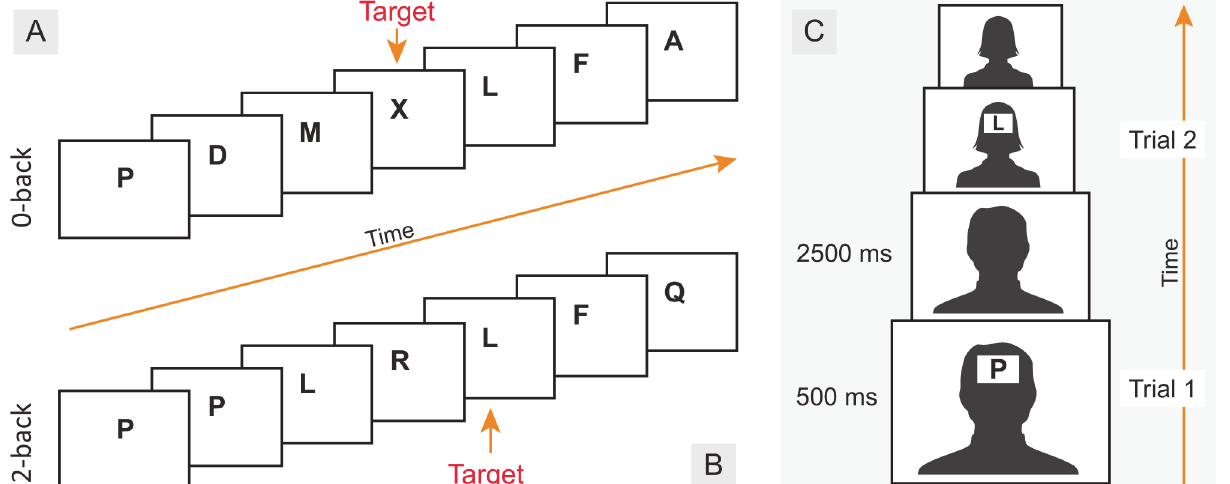
Fig 3. Illustration of the n -back tasks. A. The target in the 0-back control condition is any letter designated in the instructions (e.g., X). B. the target in the 2- back memory-load condition is any repeat of a letter presented two trials back (e.g., L). C . The EM- n -back task consisted of superimposing the original n -back task onto one of four backgrounds (no background, negative face stimuli, neutral face stimuli, and positive face